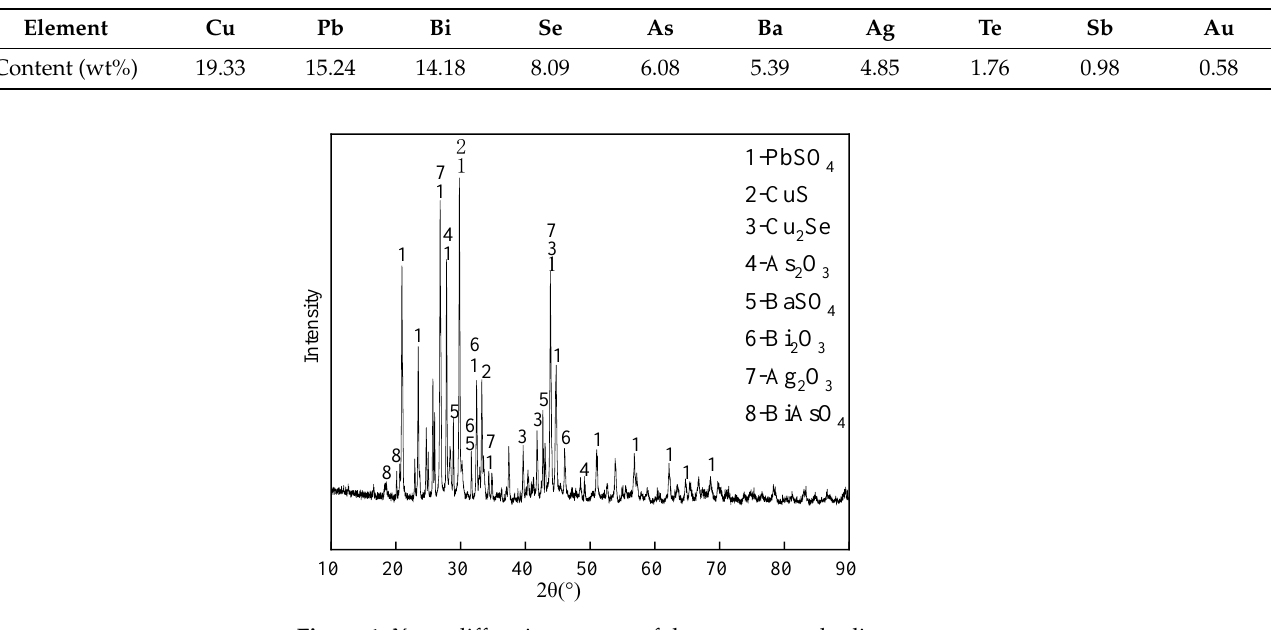
Figure 1. X-ray diffraction pattern of the copper anode slime.